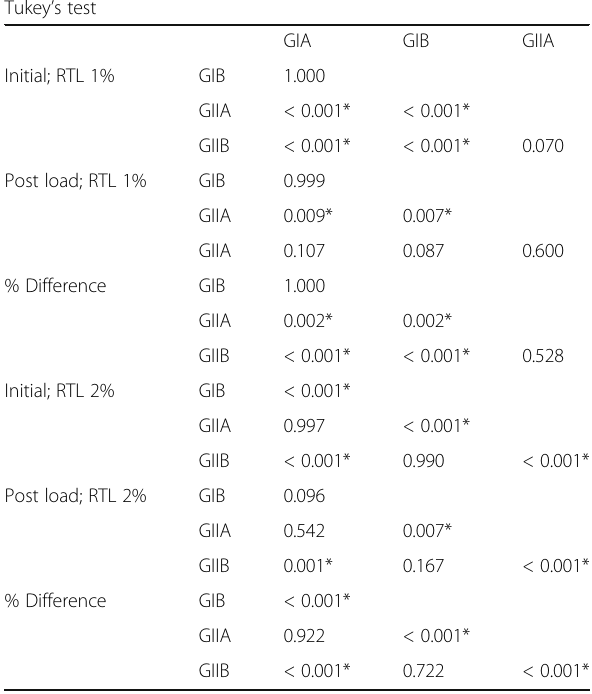
Table 8 Pair wise Tukey ’ s post hoc test between all subgroups regarding percentage initial, percentage post load, and percentage difference between initial and post load